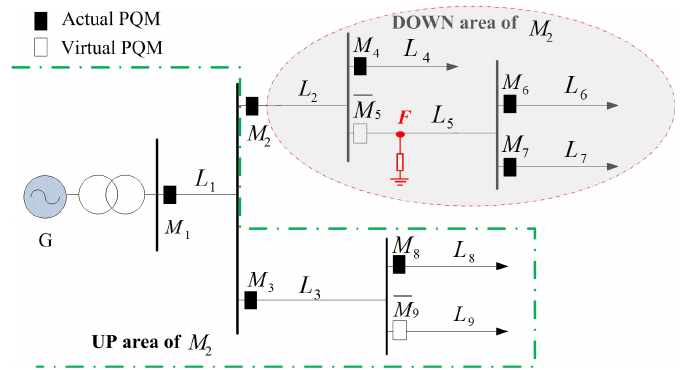
Figure 1. Topology of a simple grid and definition of DOWN/UP area.